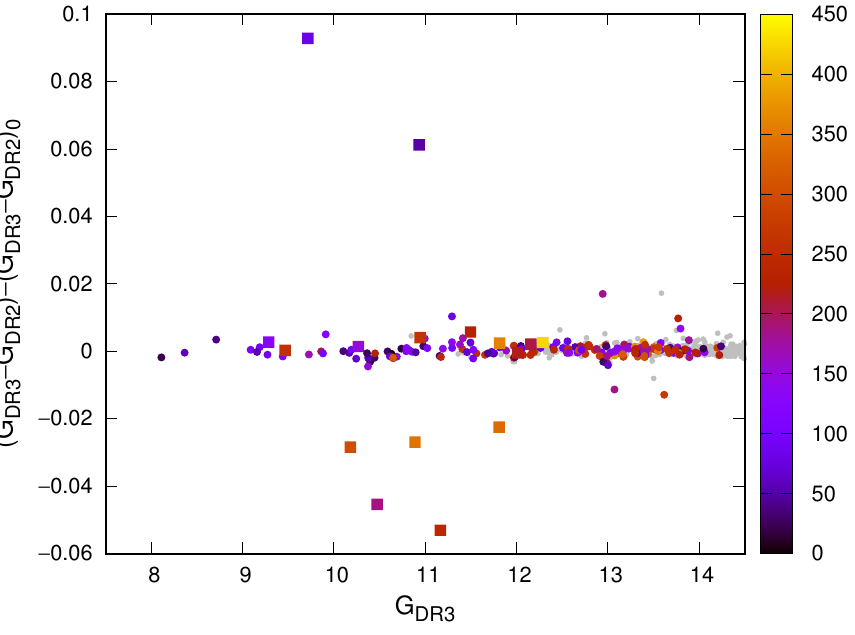
Figure 5. Similar to Figure 1b, but normalized to the stable star sequence, color coded according their projected rotational velocity (in units of kms − 1